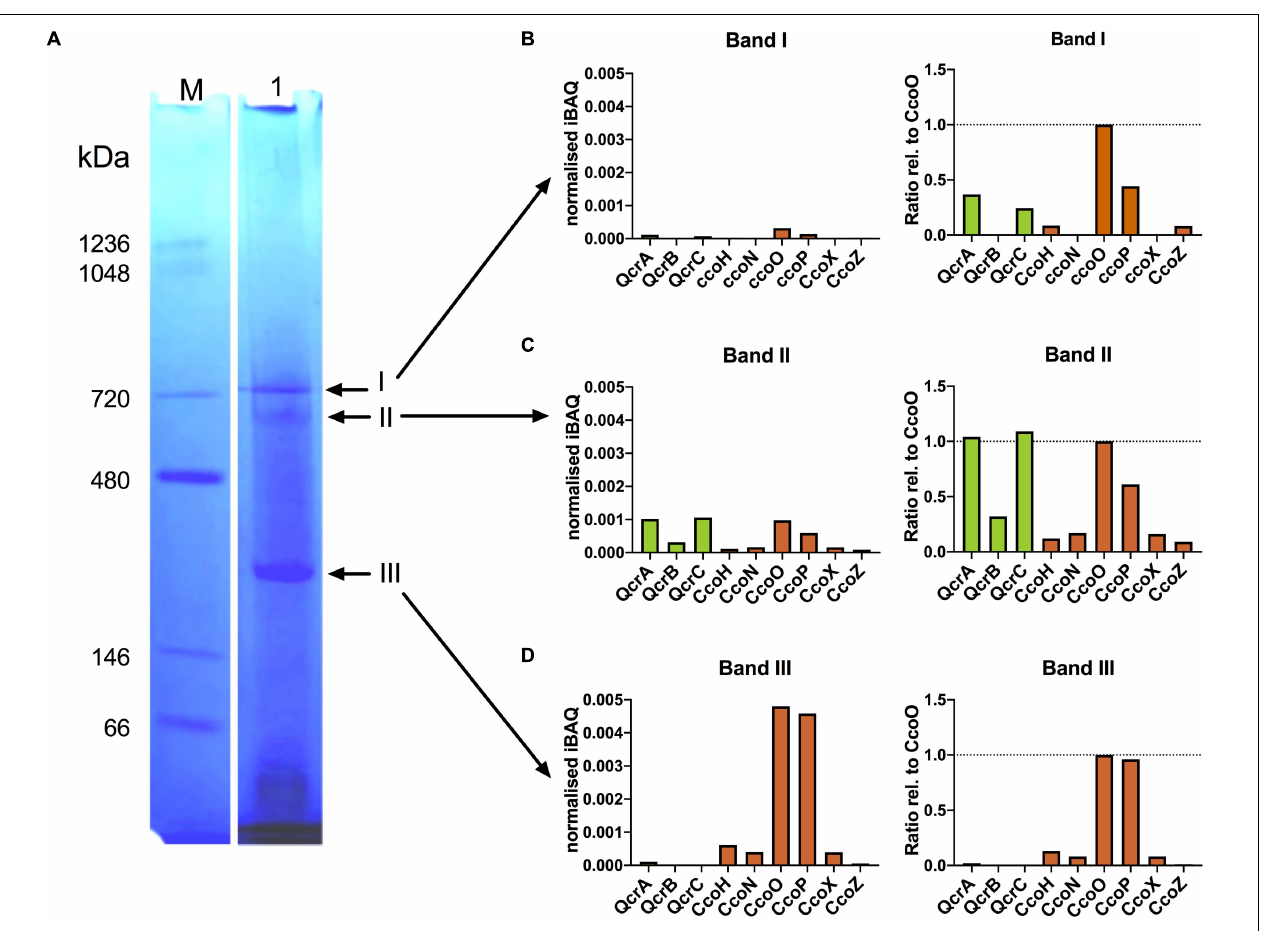
FIGURE 6 | Mass spectrometry reveals co-migration of putative Qcr-oxidase supercomplex components in blue-native PAGE. (A) BN-PAGE analysis of solubilised membrane fractions from C. jejuni . Membranes solubilised with 2% (w/v) α DDM were subjected to BN-PAGE separation as described in “Materials and Methods” ( Lane 1 ). Arrows indicate bands (I–III) excised and subjected to in-gel tryptic digestion and analysed by mass spectrometry. Lane M contains molecular size markers. (B–D) Mass spectrometry-based quantification of Qcr (green) and Cco (brown) proteins by median iBAQ ( left panels ), and protein abundance ratios relative to CcoO ( right panels ), for excised gel bands